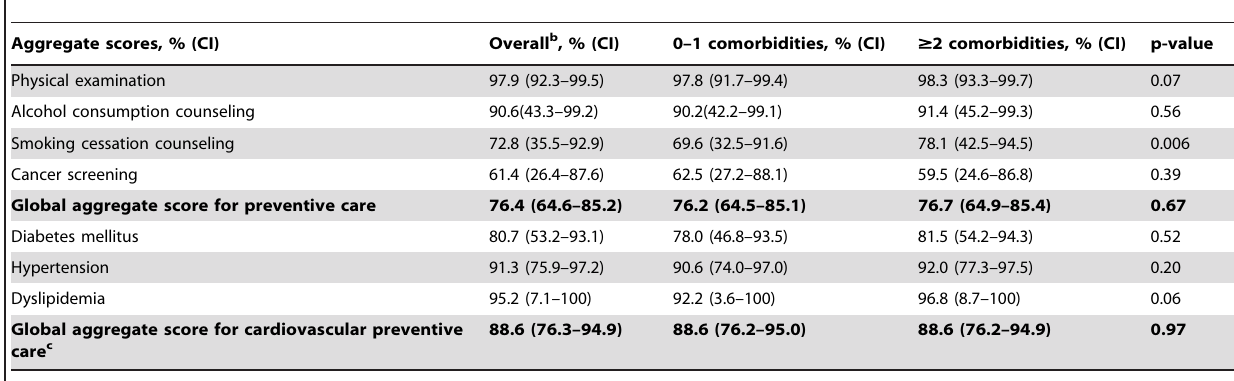
Table 3. Adjusted aggregate scores of provided as recommended preventive care and cardiovascular preventive carea: adjusted data a